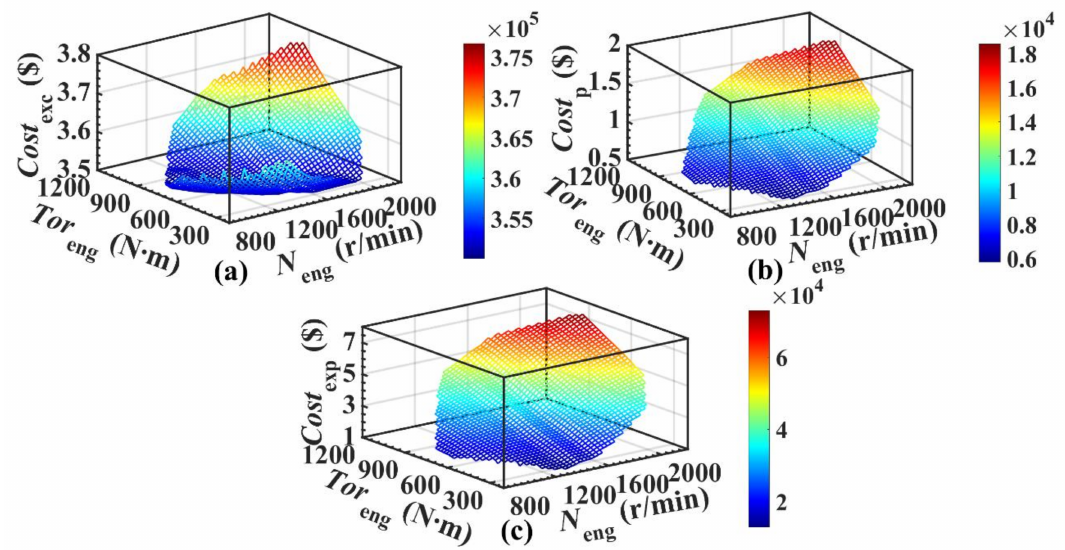
Figure 15. Dynamic response characteristics of key components total cost under full operating conditions. ( a ) dynamic response characteristics of the total investment cost of the heat exchangers. ( b ) dynamic response characteristics of the total investment cost of the working fluid pumps. ( c ) dynamic response characteristics of the total investment cost of the expanders.